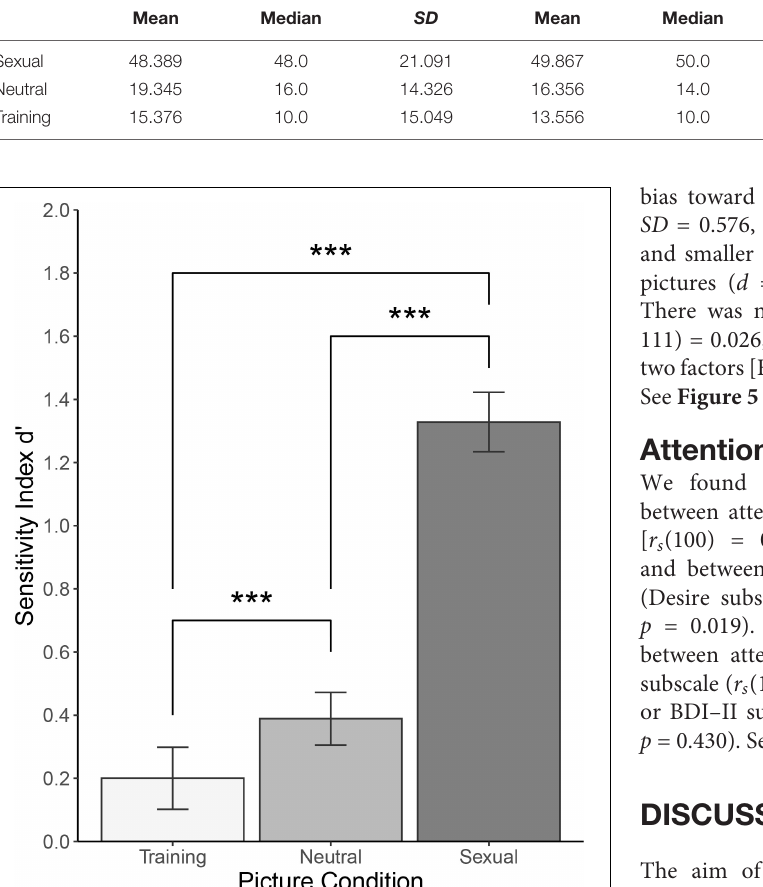
using Bonferroni correction revealed that participants showed greater sensitivity to sexual pictures ( M = 1.328, SD =